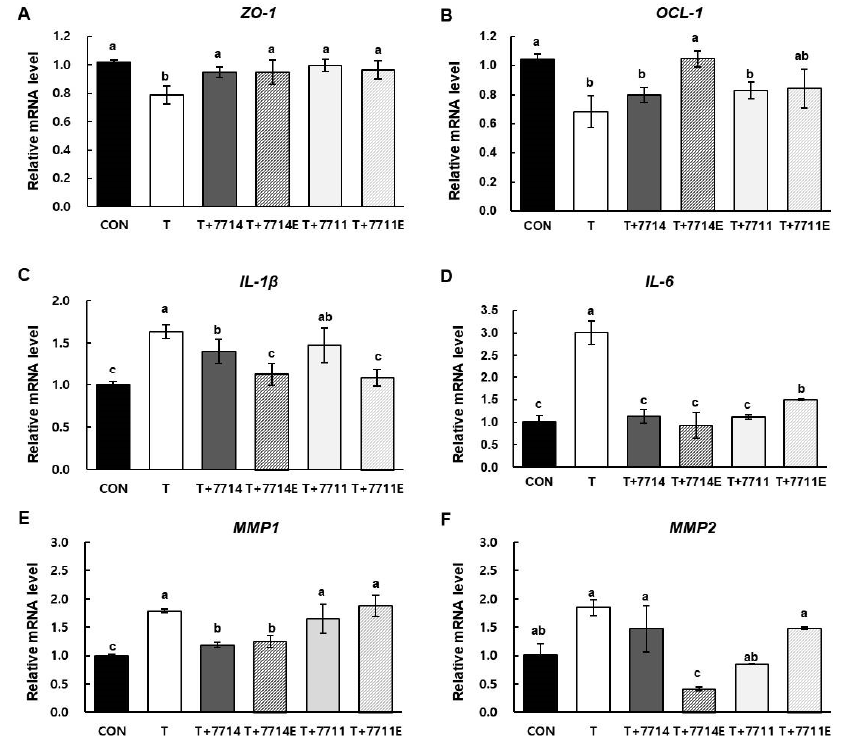
Figure 2. Effect of L. plantarum and their EPS on intestinal adhesion and inflammation in Caco-2 cells. Relative mRNA expression levels of ( A ) ZO-1 , ( B ) OCL-1 , ( C ) IL-1 β , ( D ) IL-6 , ( E ) MMP1 , and ( F ) MMP2 in Caco-2 cells were investigated by qPCR and normalized against GAPDH. mRNA data are expressed as means ± SD ( n = 4), and values labeled with different letters are significantly different, p < 0.05 (a > b > c > d). CON, control cells; T, cells treated with 100 ng/mL TNF α ; T+7714,